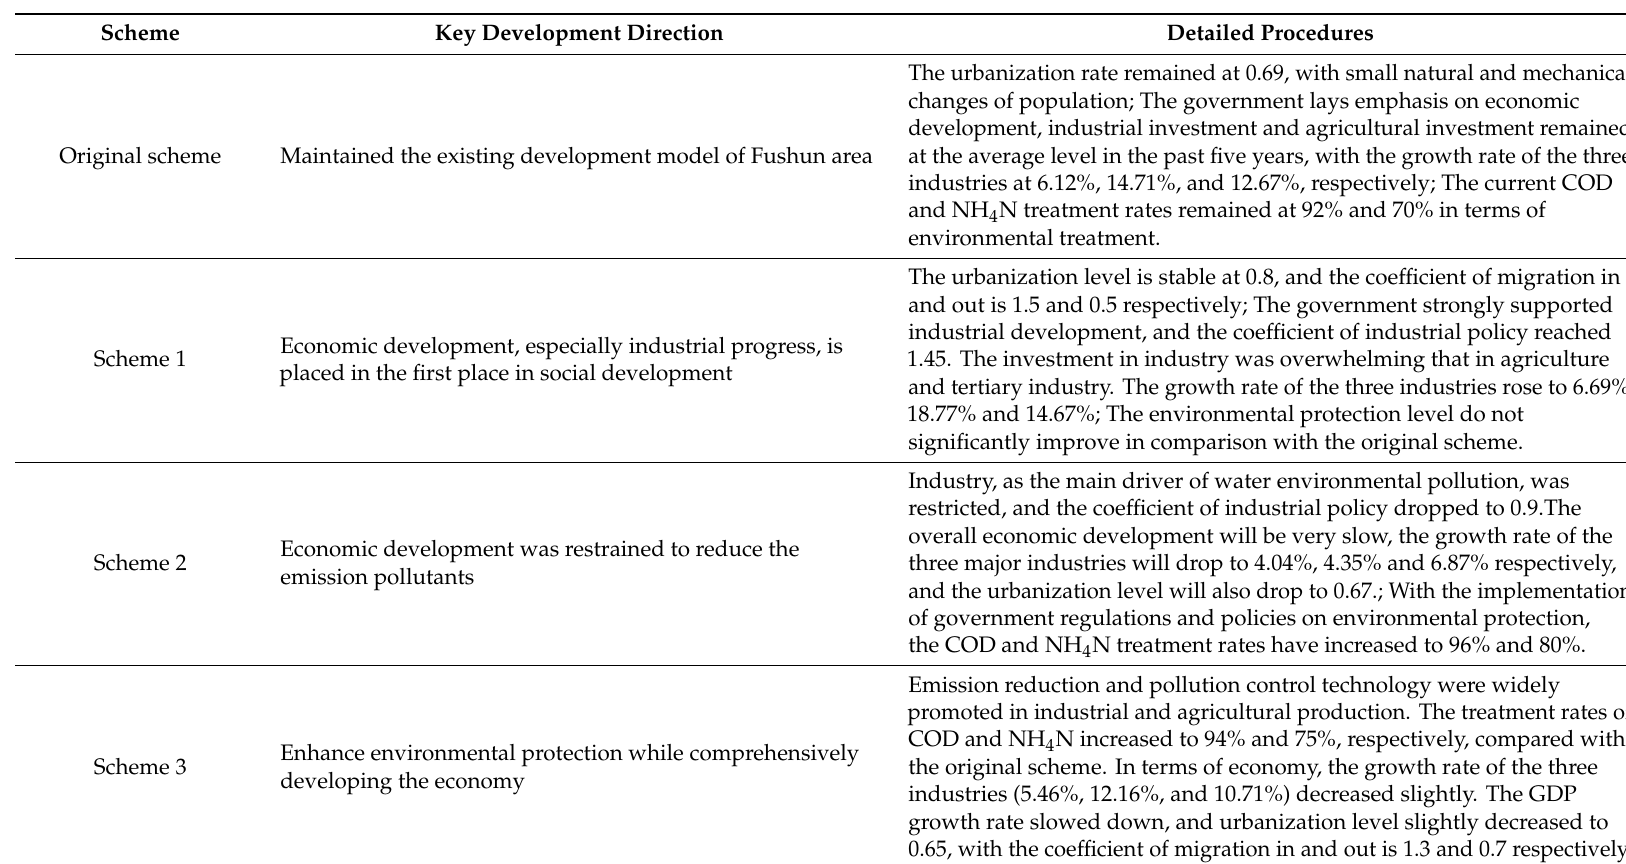
Table 5. Improvement schemes of water environment carrying capacity in Fushun